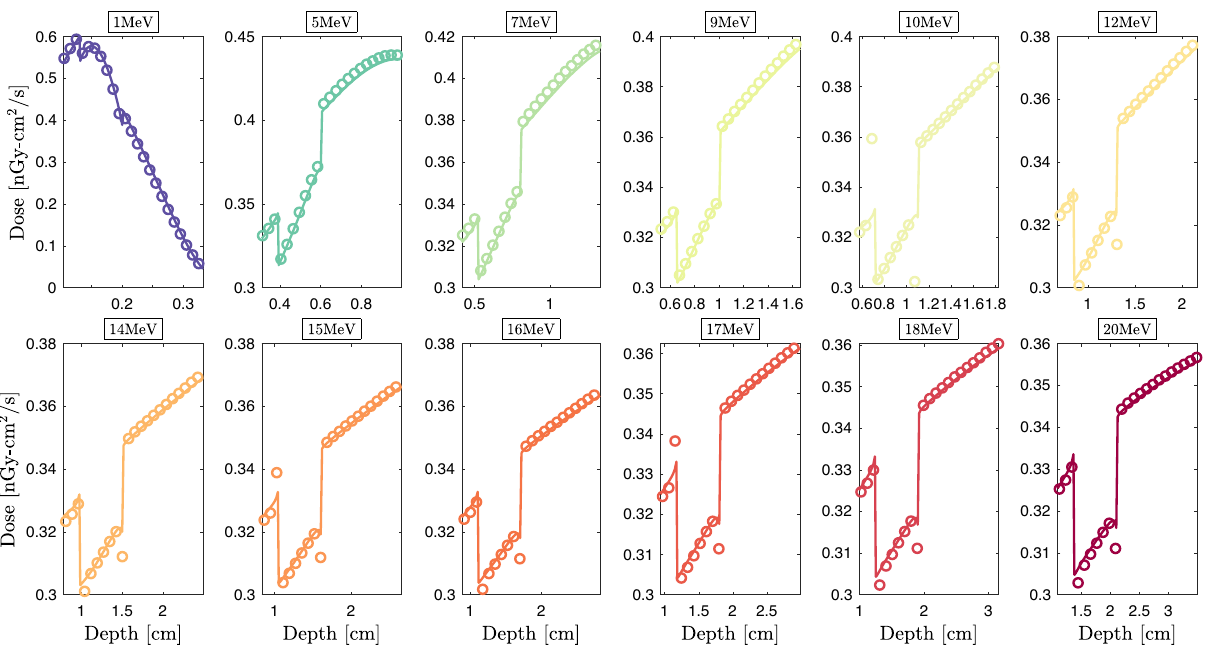
Figure 3. Njoy-Dragon-5 depth-dose curves ( solid lines ) compared to Geant-4 [ G4EmLivermore ( circles )] for incident unidirectional electron beams around the T-bone’s slab. Showed slabs include from the left to the right : water, bone and lung tissue. Dimensions are fixed to the incident beam’s range. MC convergences are obtained for a 0.2% mean standard deviation.